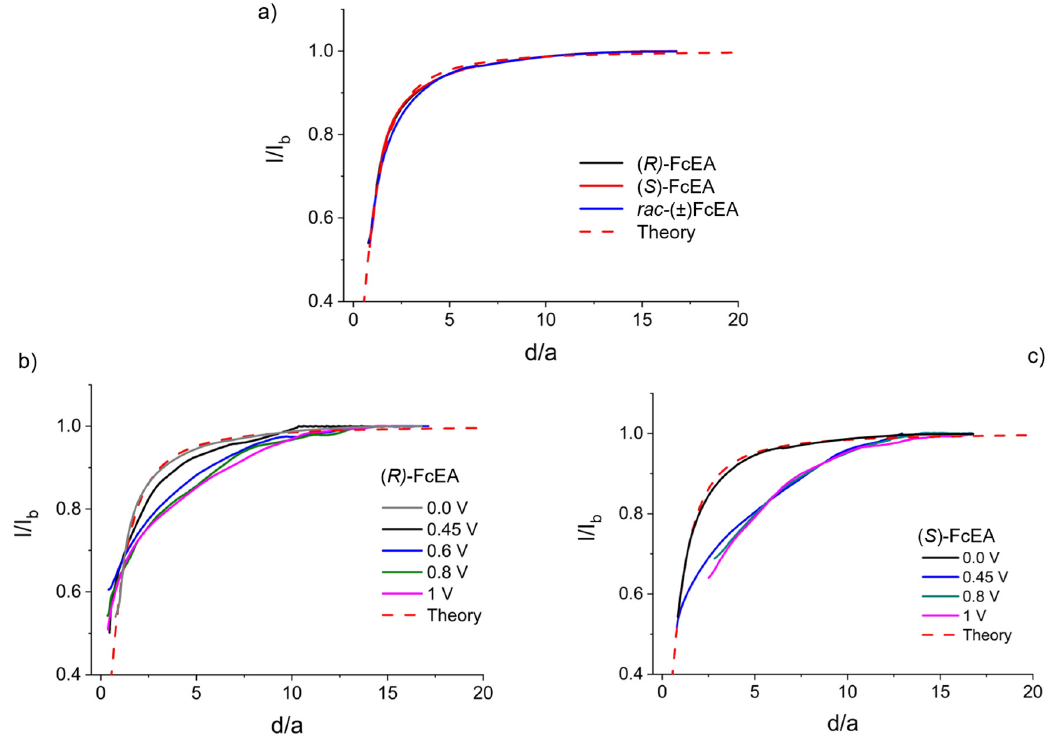
Figure 10. Approach curves recorded in 2 mM of ( S )-FcEA or and 1 mM ( R )-FcEA CH 3 CN solution with a Pt microdisk 12.5 µm radius, biased at 0.5 V, above the unbiased oligo-( S )-BT 2 T 4 -Au ( a ) and biased at different potentials ( b ) and ( c ) as indicated. Approach curves with dashed red lines refer to the theory for negative and positive feedback.